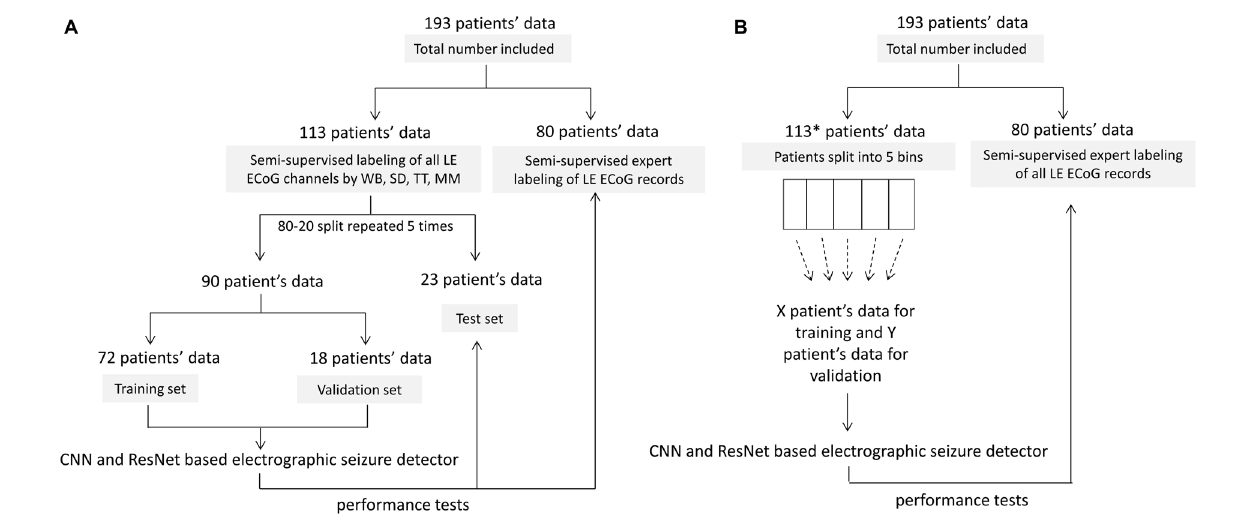
FIGURE 2 | Patient splits for labeling, training, validating and testing electrographic seizure classifier models. (A) Patient splits for training and testing electrocorticographic (ECoG) channel-level and ECoG record-level classification models with 80% patients’ data used for training and validation, and 20% patients’ data used for testing. The trained models were tested on individual ECoG channels within ECoG records from the 23 held-out patients in each training fold, to generate ECoG channel-level classification test metrics. The trained models were additionally tested on an independent expert-labeled dataset from 80 patients with seizure or non-seizure ECoG record-level labels. In this case, model predictions on individual ECoG channels within ECoG records were combined with the OR operator applied to the seizure classification to produce ECoG record-level predictions. These were compared with expert labels to generate ECoG record-level classification test metrics. (B) 10-80 patient splits for characterizing model performance as a function of amount of training data. *8 out of 113 patients did not have ECoG channels with the ‘seizure’ label and were not included in this analysis. This was done to avoid creating training datasets (especially the ones with data from small number of patients) with highly skewed number of examples of seizure and non-seizure classifications. The remaining 105 patients were split into 5 bins (with 21 patients in each bin) based on the number of labeled ECoG records available in the patient. Patients were uniformly and randomly selected from each of the 5 bins to create the 10-80 patient training sets. The 20 patient training set, for example, contained four patients randomly selected from each of the 5 bins. The trained models were tested on ECoG records from 80 patients independently labeled by an expert. Note that unlike in panel (A) , the only test dataset used in this case was the expert labeled dataset from 80